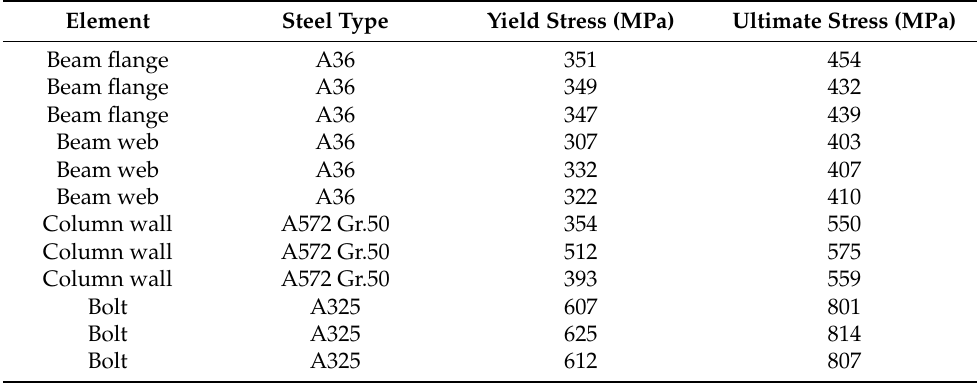
Table 1. Material properties of